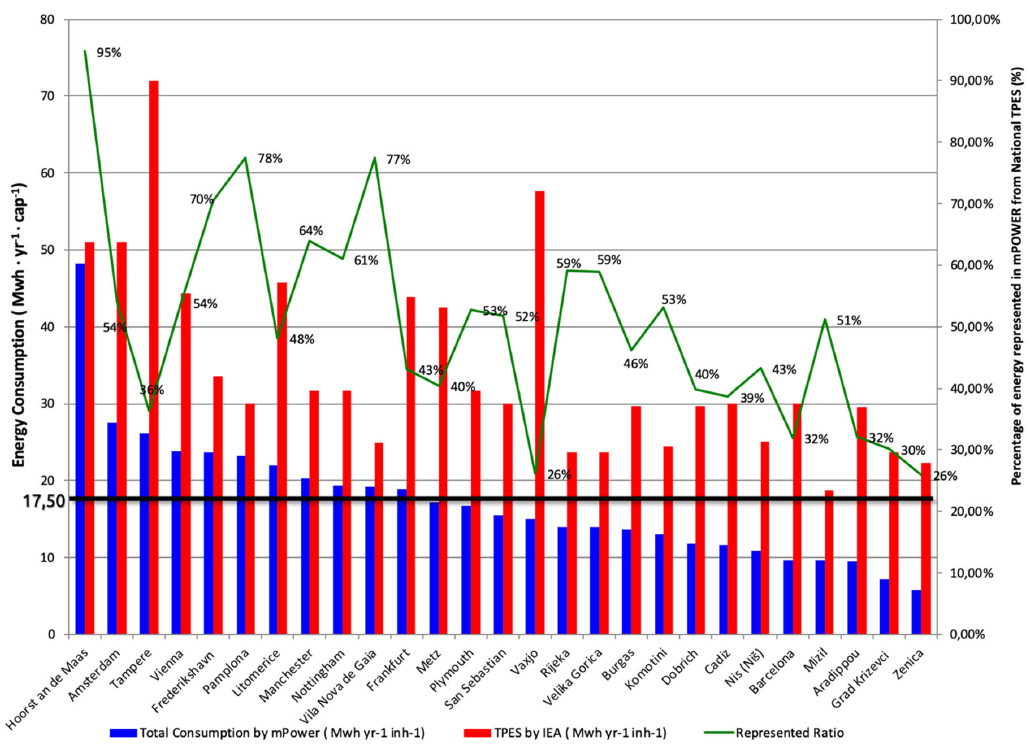
Figure 3. The total energy consumption by inhabitant computed for the selected cities (by mPOWER project) and the national reality reflected by the International Energy Agency averages. The goal in